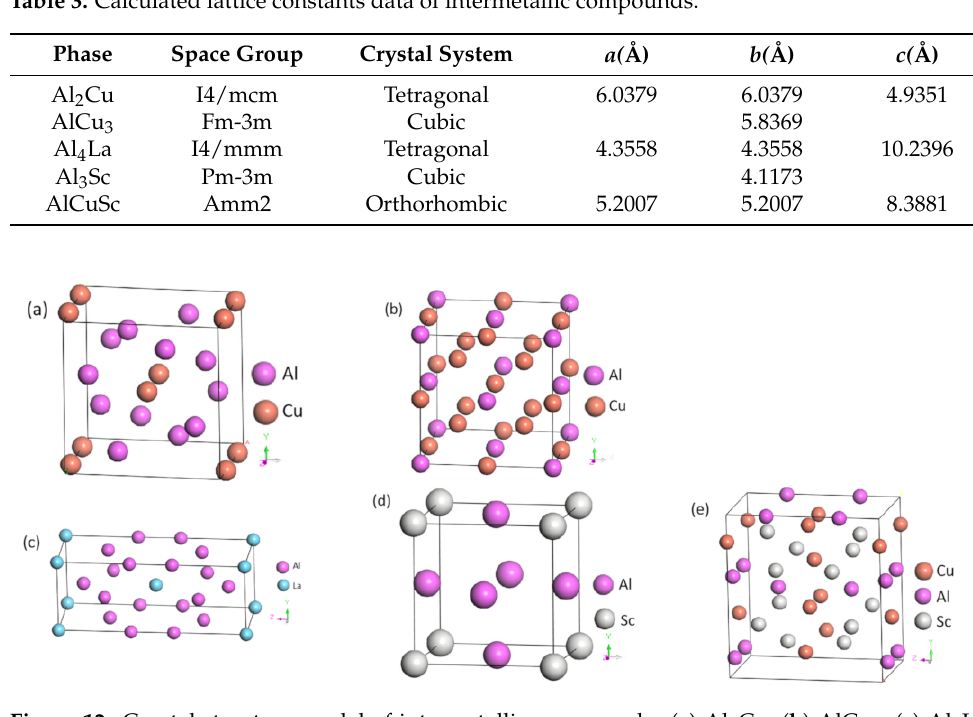
Figure 12. Crystal structure model of intermetallic compounds. ( a ) Al 2 Cu, ( b ) AlCu 3 , ( c ) Al 4 La, ( d ) Al 3 Sc, ( e )